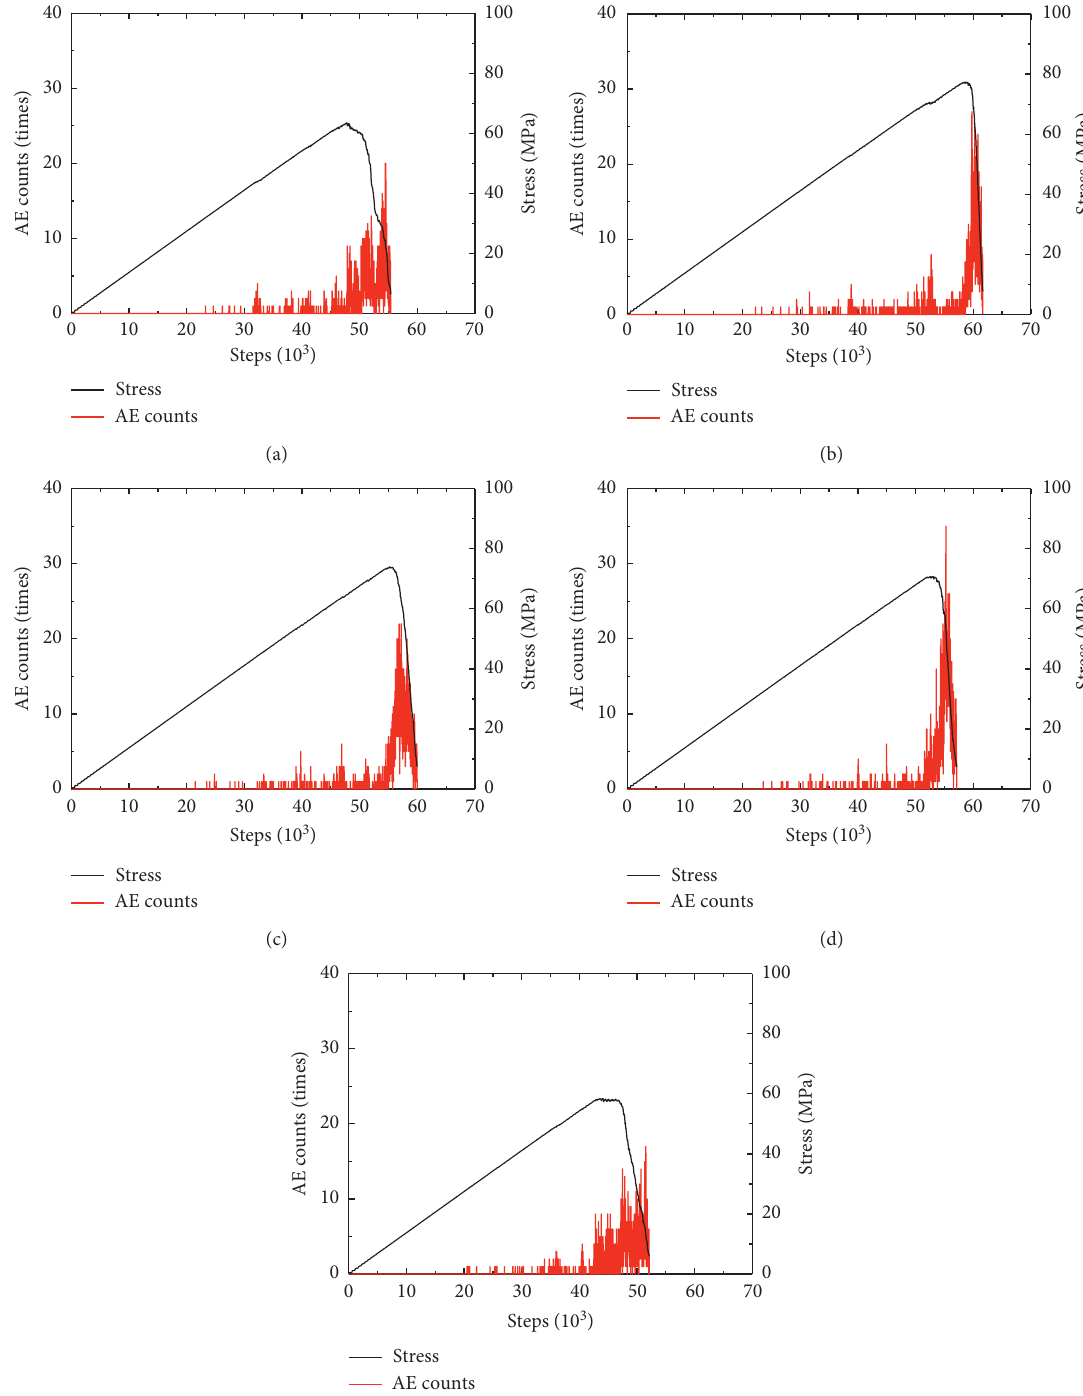
Figure 16: Stress-time-AE counts of samples with different borehole height ratio. The R of (a), (b), (c), (d), and (e) are 0.1, 0.3, 0.5, 0.7, and 0.9,